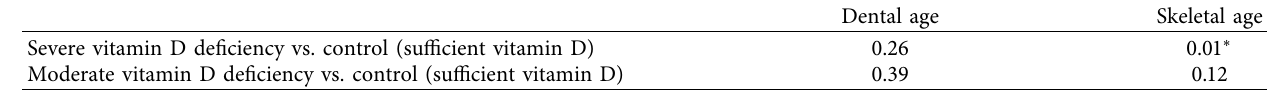
Table 3: P value ∗ measurements for paired comparisons of dental age and skeletal age among the study groups. Dental age Skeletal age Severe vitamin D defciency vs. control (sufcient vitamin D) 0.26 0.01 ∗ Moderate vitamin D defciency vs. control (sufcient vitamin D) 0.39